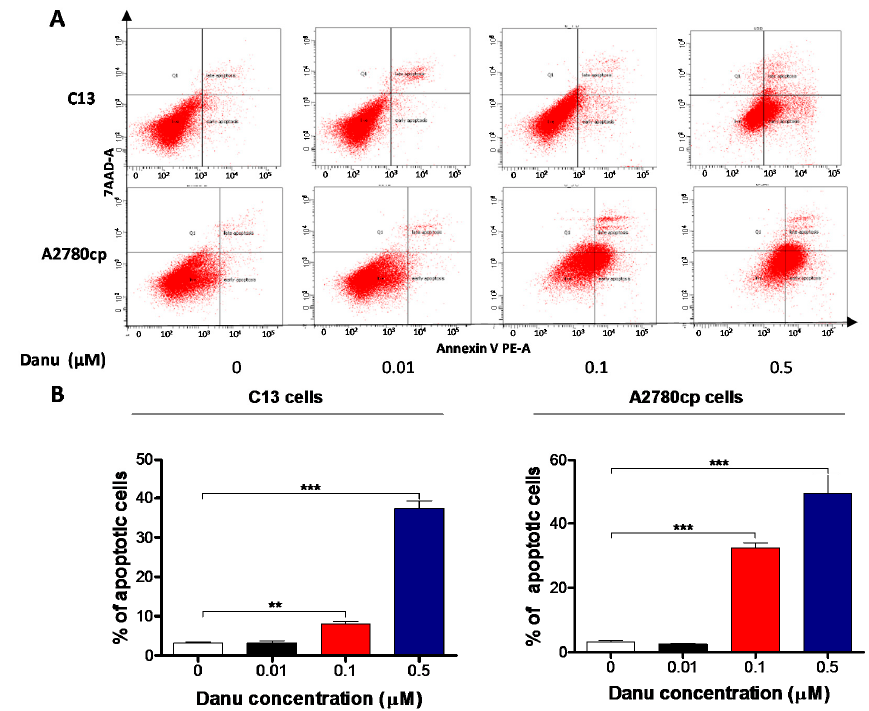
Figure 5. Danu induces apoptotic cell death in C13 and A2780cp cells. C13 and A2780cp cells were incubated with Danu 0.01, 0.1, and 0.5 µ M for 48 h and then subject to flow cytometry. ( A ) Flow cytometric plots of specific cell population (live, early apoptosis, and late apoptosis) in C13 and A2780cp cells and ( B ) bar graphs showing the percentage of apoptosis of C13 and A2780cp cells. Data represent the mean ˘ SD of three independent experiments.** p < 0.01 and *** p < 0.001 by one-way analysis of variance.